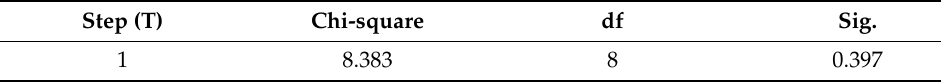
Table 5. Hosmer-Lemeshow